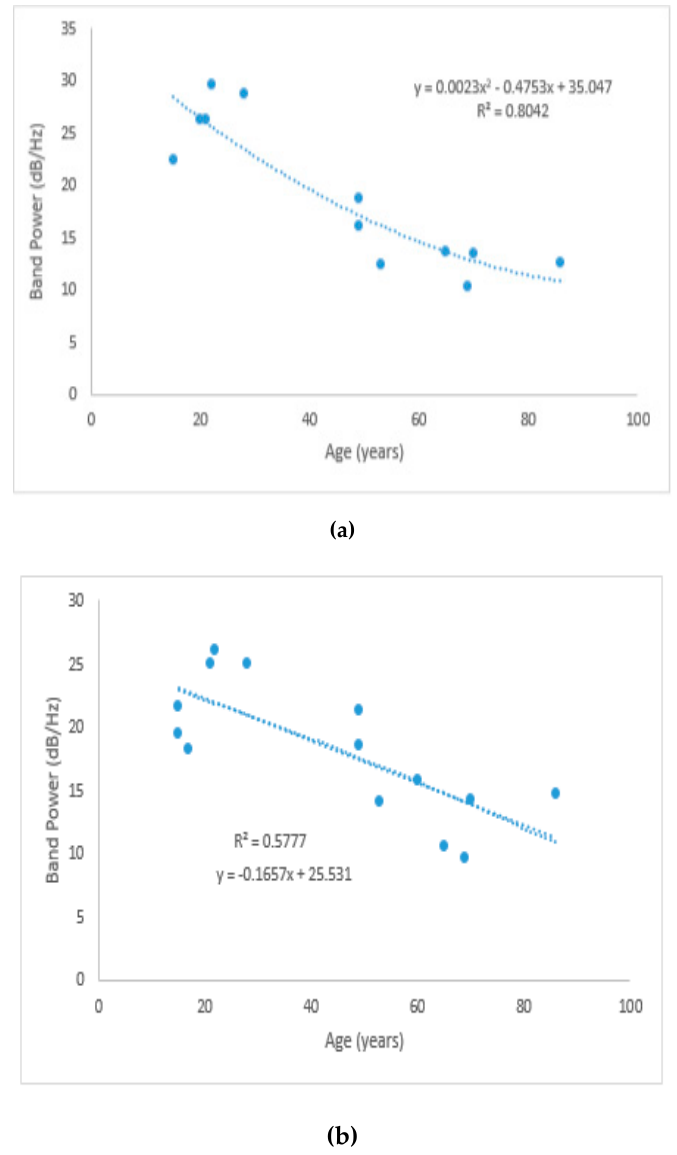
Figure 3. Band power (dB/Hz) of SSVEPs evoked by ( a ) theta and ( b ) alpha frequencies .